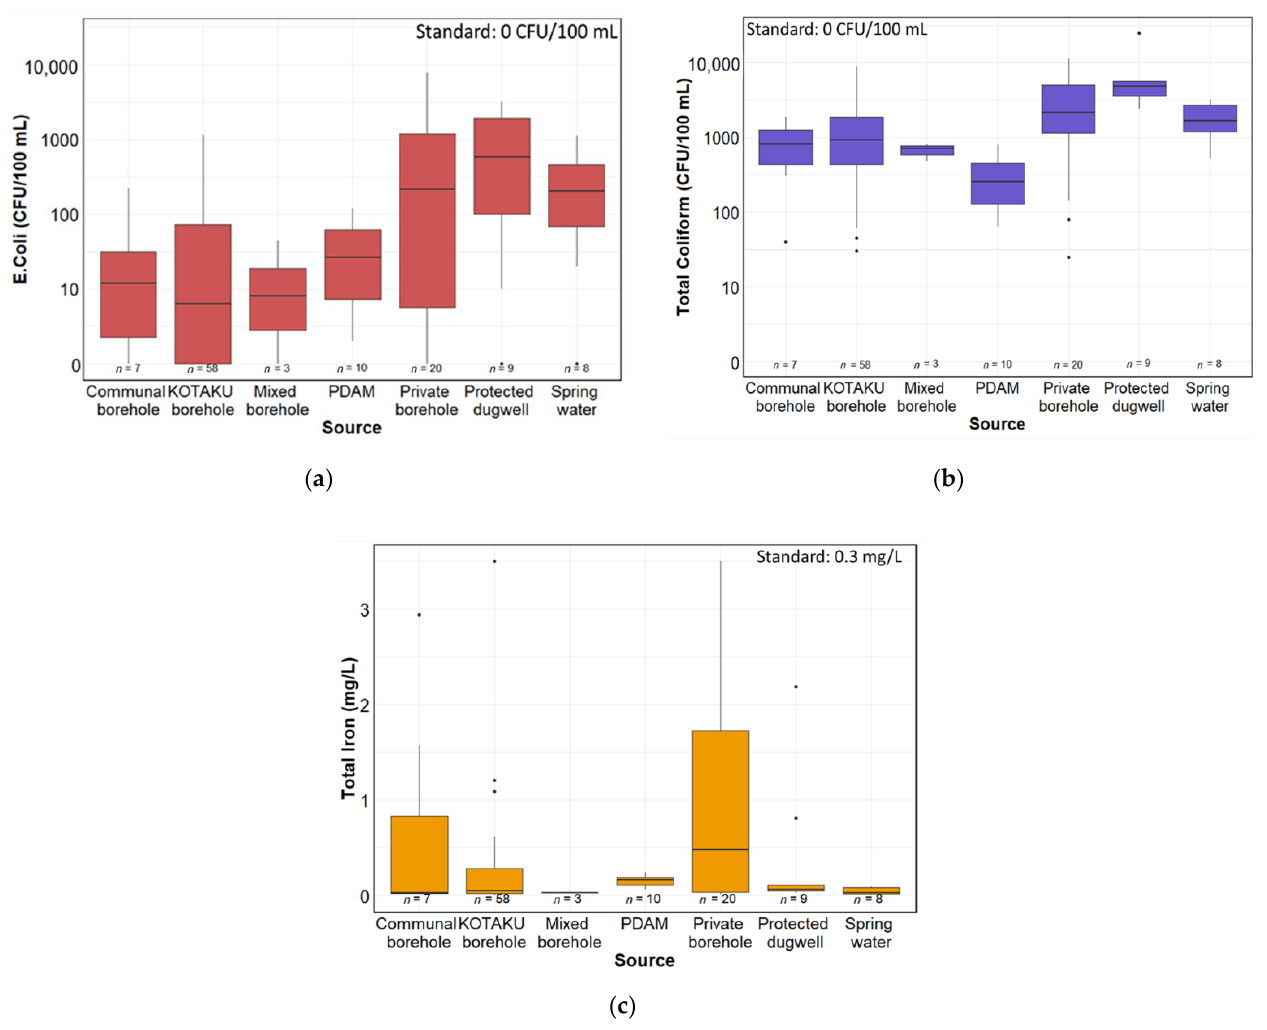
Figure 6. Water quality: ( a ) E. coli , ( b ) total coliform, and ( c ) total iron. Although the lowest detection rate of E. coli was observed in the KOTAKU borehole samples (30 out of 58, 48%), the concentration of E. coli varied among the samples (0–1140 CFU/mL). E. coli was also found in 6 out of 17 samples (35%) collected directly from the KOTAKU boreholes with a range of 10–68 CFU/100 mL, while total coliform was detected in all the 17 samples with a range of 5–2012 CFU/100 mL. Out of the KOTAKU borehole samples collected from the taps and household storage, 37% (11/30) and 53% (9/17), respectively, had higher concentration of E. coli than its source. Moreover, 20% (6/30) of the samples from the taps and 29% (5/17) from the household storage had a one log or more higher concentration than their source. Similarly, a higher concentration of total coliform than that in the sources was found in 63% (19/30) and 82% (14/17) of the samples from the taps and storage, respectively; among them, 26% (8/30) from the taps and 24% (4/17) from storage had a concentration of one or two logs higher of total coliform than its source. This implied fecal contamination of the KOTAKU borehole water (source itself) in the taps and storage. Both E. coli and total coliform were detected in all the PDAM samples despite the fact that the PDAM was the only water source with disinfection. Since E. coli and total coliform were also detected in the samples collected at taps, the low concentration of free chlorine (0.01–0.09 mg/L) and total chlorine (0.03–0.2 mg/L) is considered to be the reason for microbial contamination of the PDAM samples. Both E. coli and total coliform